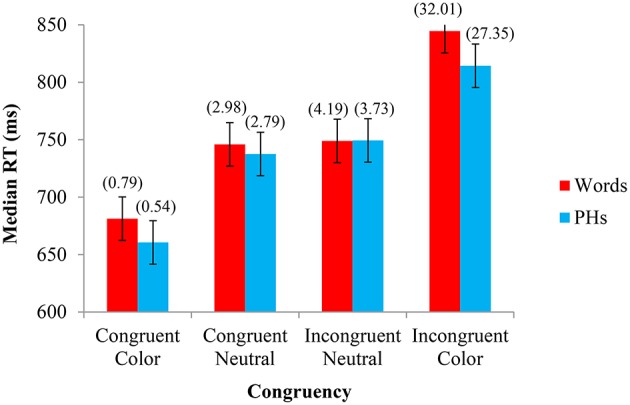
Experiment 3—Color name stimuli: Median response time (RT) and percent errors (above) in naming the font color as a function of Letter String Type (word, PH) and Congruency (congruent, neutral congruent, neutral incongruent, incongruent). The 95% confidence intervals (shown here for RT by the error bars attached to each data point) indicate that, for both word and PH stimuli, there is no difference in the time taken to respond to the congruent neutral words and the incongruent neutral words. There is, however, a significant difference between the congruent and congruent neutral conditions (congruent words responded to faster) and between the incongruent neutral and incongruent conditions (incongruent words responded to slower) for both words and PHs. The percent error confidence interval was ± 1.97%. Paired-samples t-tests support the 95% CIs for Experiment 3, whereby if the CIs reflected a significant difference, so too did the t-tests, all t's(23) > 6.598, p's < 0.001.